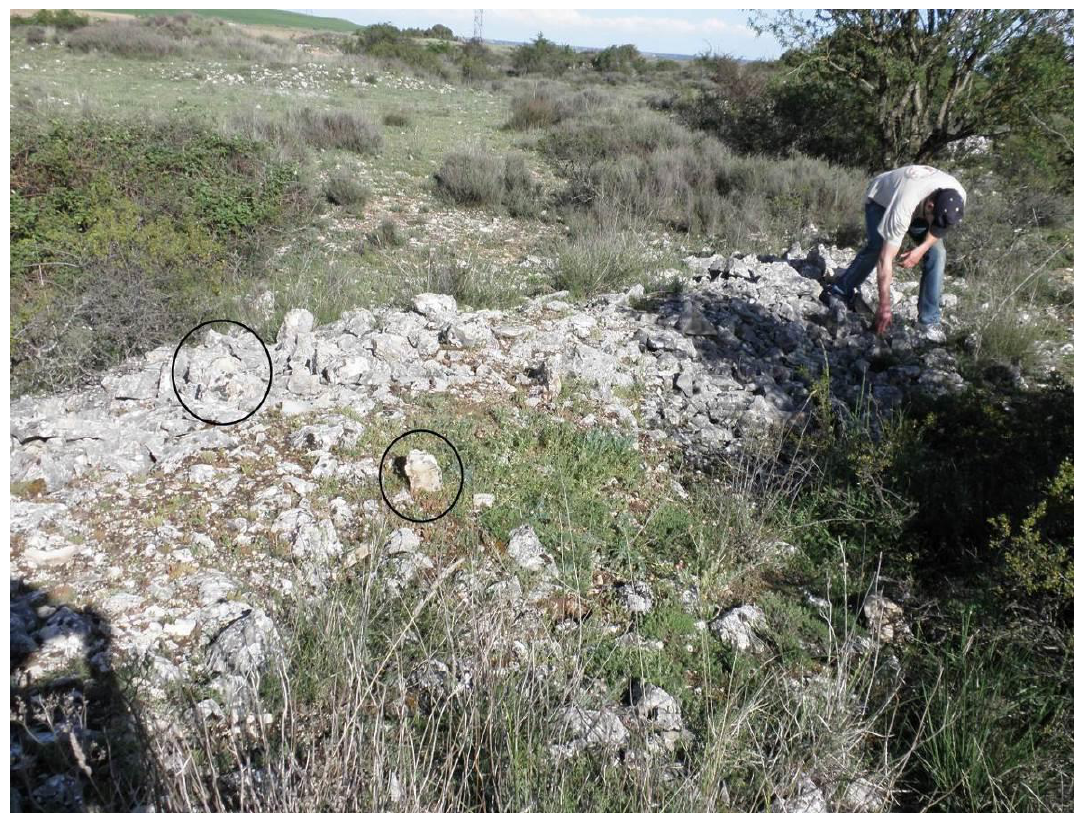
Figure 7. Loose chert nodules at Las